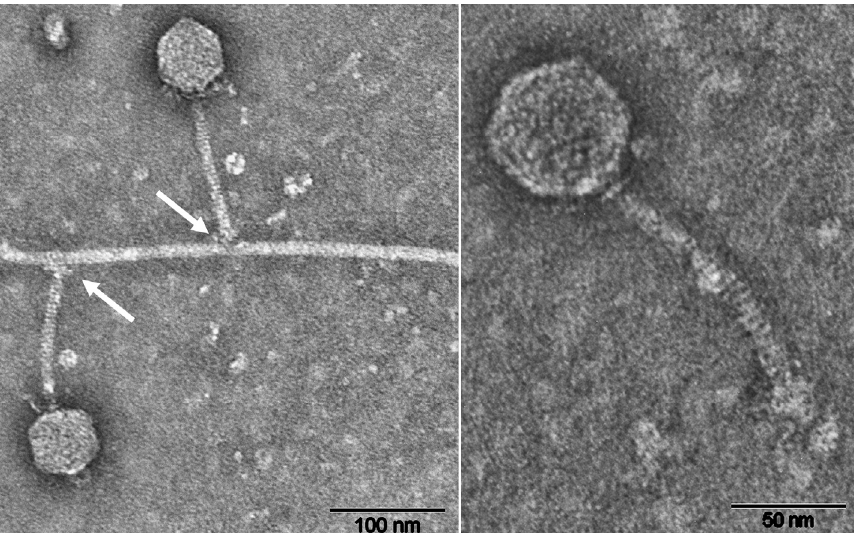
Figure 4. TEM micrographs of the Blf4 virus. Left: virus attachment to cell appendage (arrows), presumably flagellum. Right: a single virus displaying typical morphological characteristics of members of the Siphoviridae ; Blf4 contains a hexagonal head (approximately 60 nm in diameter) and a non-contractile tail (approximately 125 nm in length and 10 nm wide). The samples were negatively stained with uranyl acetate (bars = 100 nm and 50 nm in the left and right images, respectively).